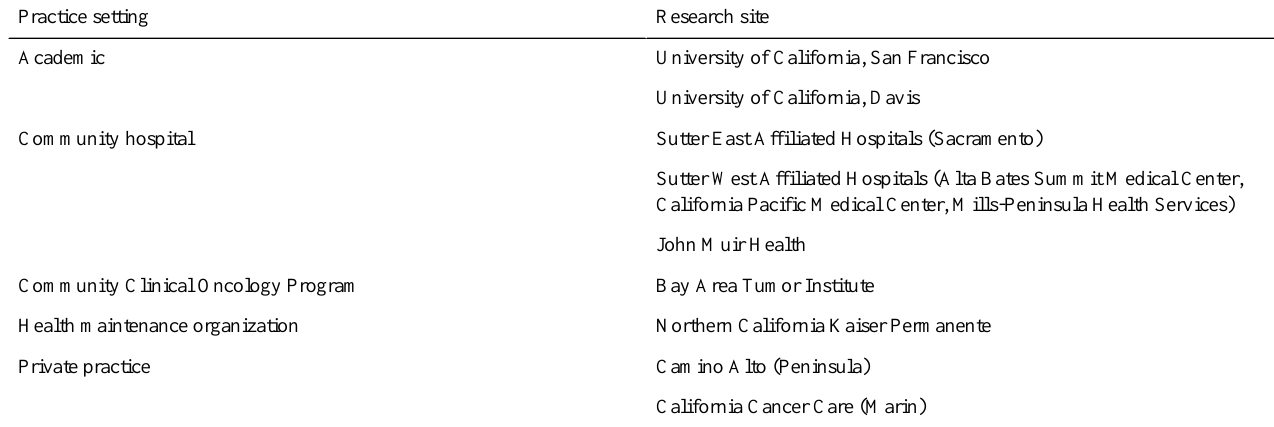
Table 1. Research sites providing trials at the launch of